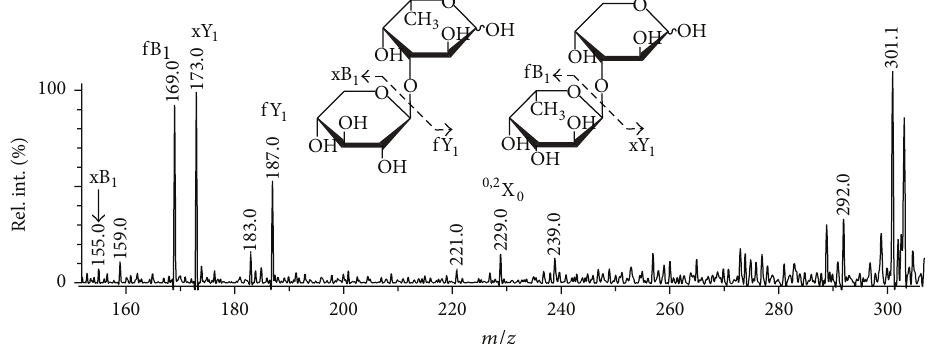
Figure 5: Positive-ion tandem MALDI-TOFMS ion at m/z